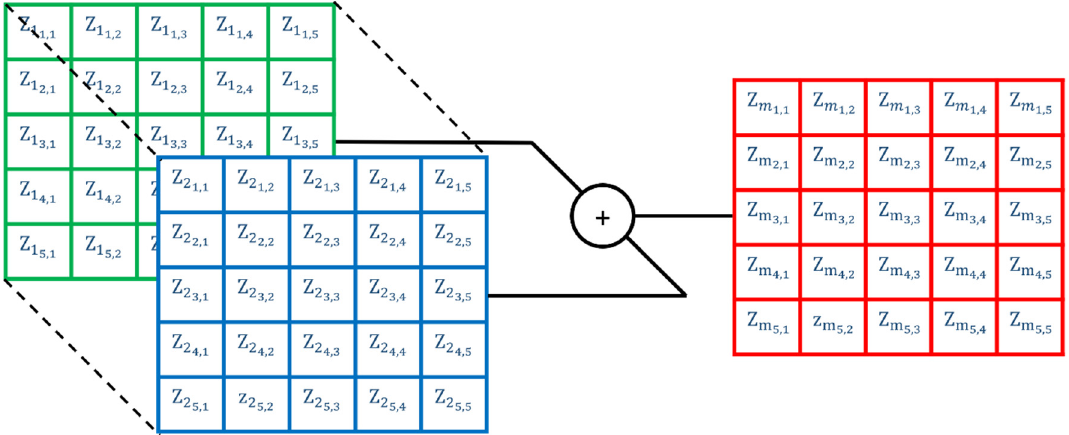
Figure 7. Illustration of mixing datasets 𝑍 (cid:2869) and 𝑍 (cid:2870) impedance data to make 𝑍 (cid:3040) mixed